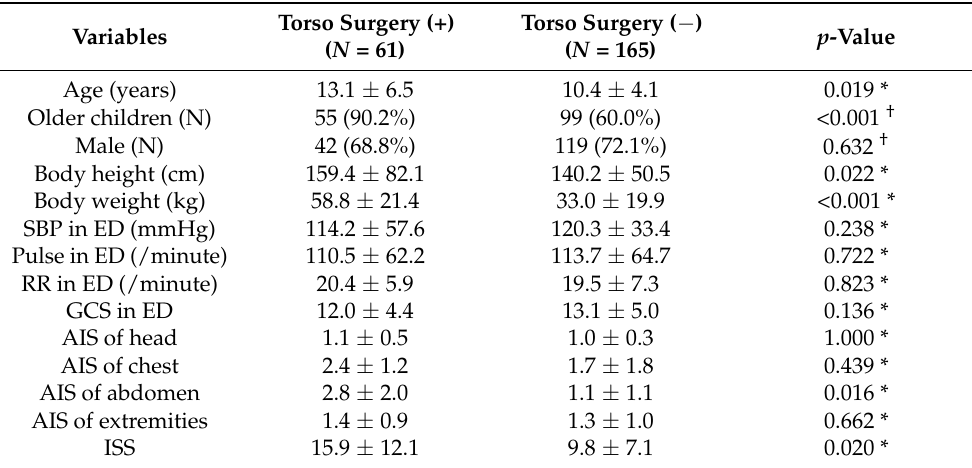
Table 1. Comparisons of characteristics between pediatric torso trauma patients who did and did not undergo surgery ( N = 226).